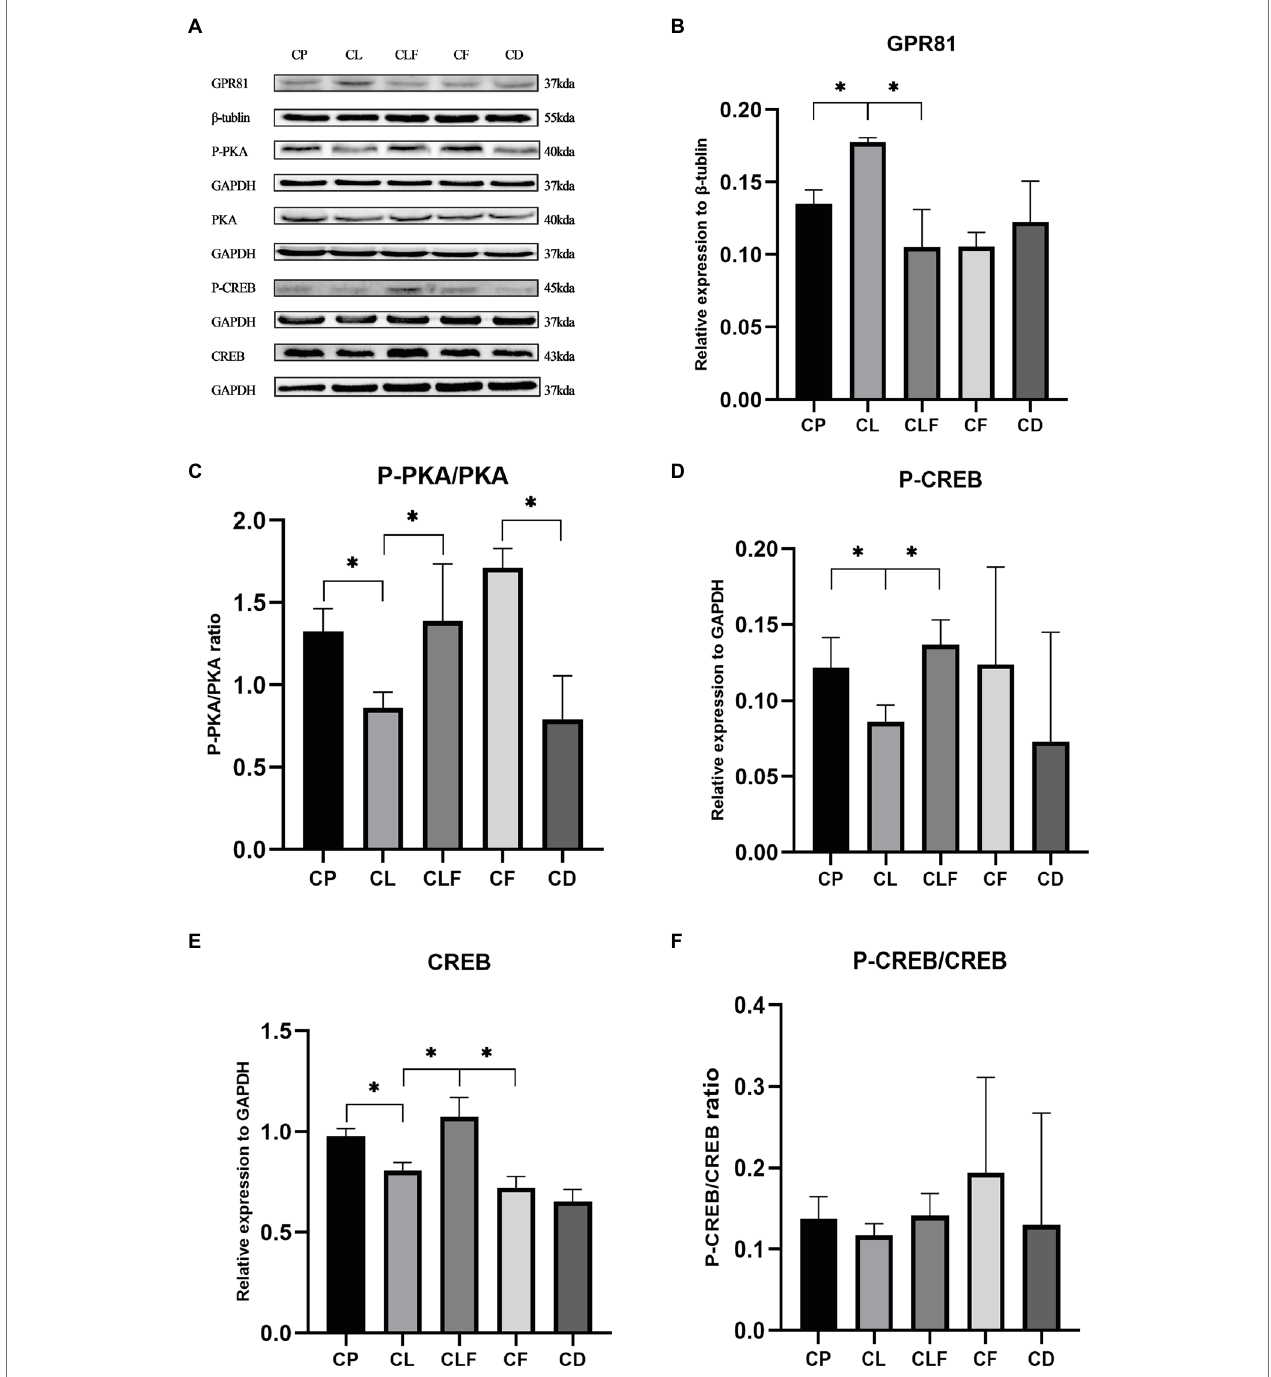
FIGURE 6 | Western blot analysis and relative fold protein expression of GPR81, P-CREB, CREB, and the ratios of P-PKA/PKA and P-CREB/CREB after chronic administration. (A) Western blot analysis of GPR81 and proteins involved in cAMP-PKA pathway. (B) Fold protein expression of GPR81. (C) The ratio of P-PKA/PKA. (D) Fold protein expression of P-CREB. (E) Fold protein expression of CREB. (F) The ratio of P-CREB/CREB. Three bands are used for statistics. The data are presented as the mean ± SD, and significant differences among the groups were analyzed with one-way ANOVA. * p <